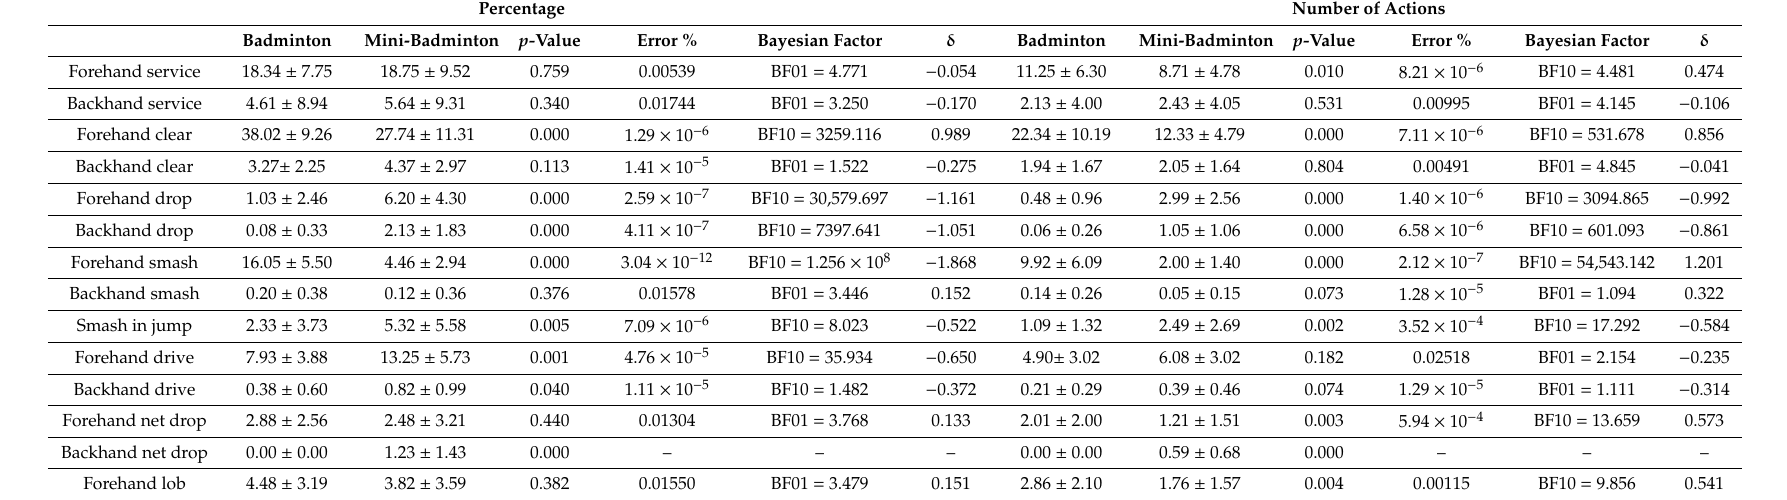
Table 4. Bayesian analysis of usage percentage and stock count technical and tactical according to kinds of technical and tactical